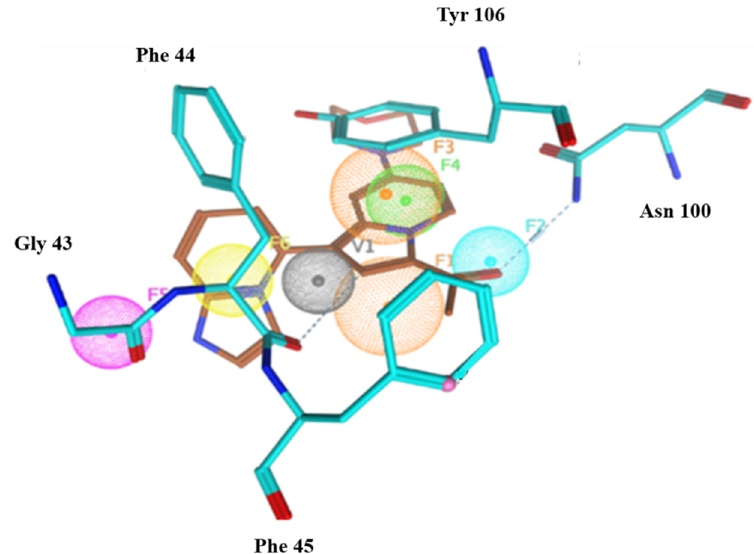
Figure 4. The selected structure-based pharmacophore model generated via MOE 2018 [22] com- posed of six key features involving donor and acceptor features towards Gly and Asn, respectively, a hydrophobic feature near Tyr106 and two aromatic features near Phe44 and Tyr106.